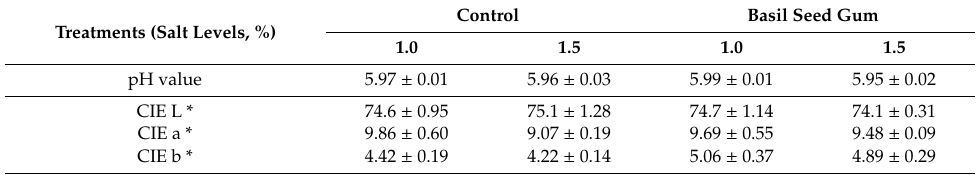
Table 5. pH and color values of low-fat sausages with basil seed gum at di ff erent salt levels. Treatments (Salt Levels,